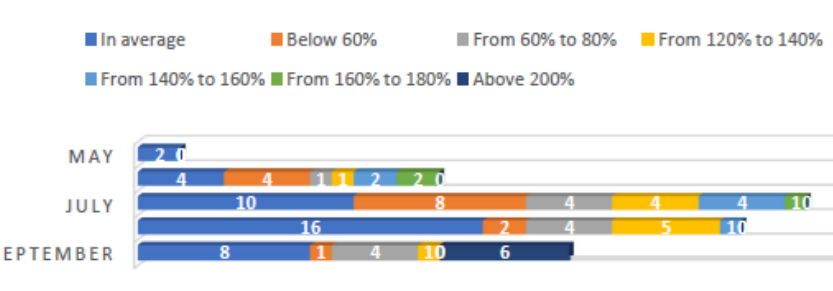
Figure 9. Daily CDD variations over specific months (indicating the number of days).